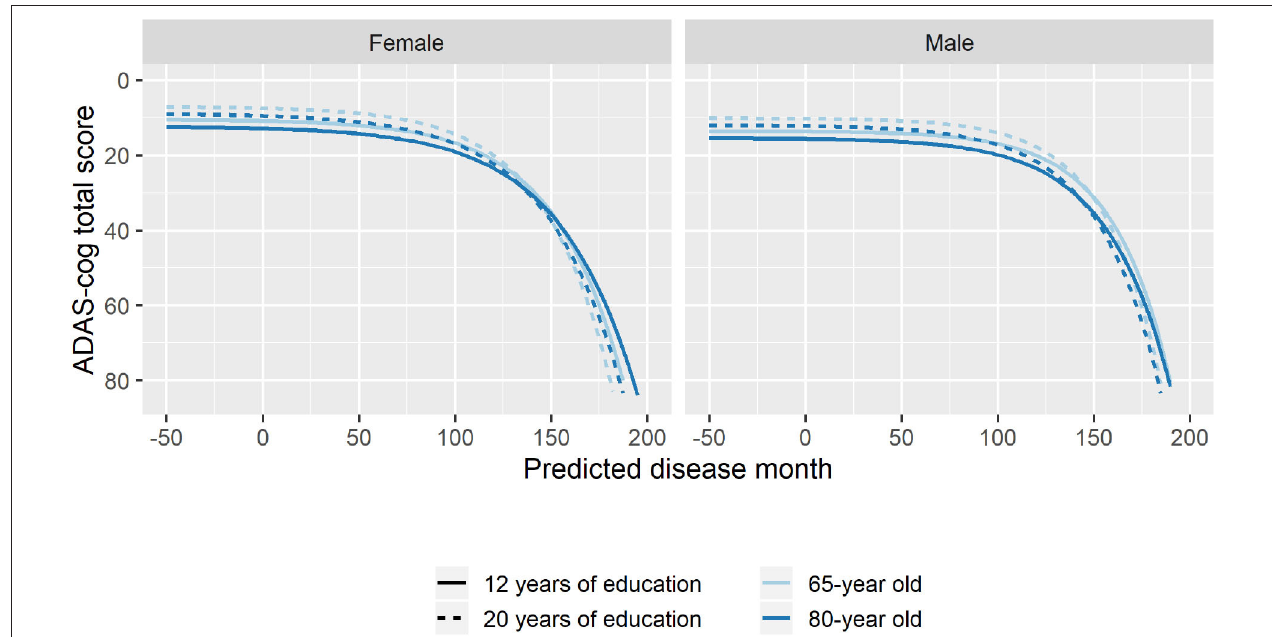
FIGURE 7 | Estimated trajectories for different combination of patient age, sex, and length of education. The trajectories are aligned at predicted month 0 that corresponds to the average cognitive stage of cognitively normal individuals at baseline.